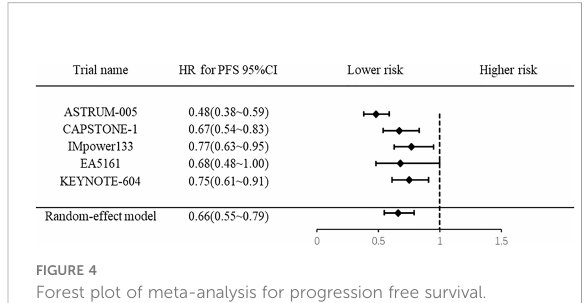
FIGURE 4 Forest plot of meta-analysis for progression free survival.